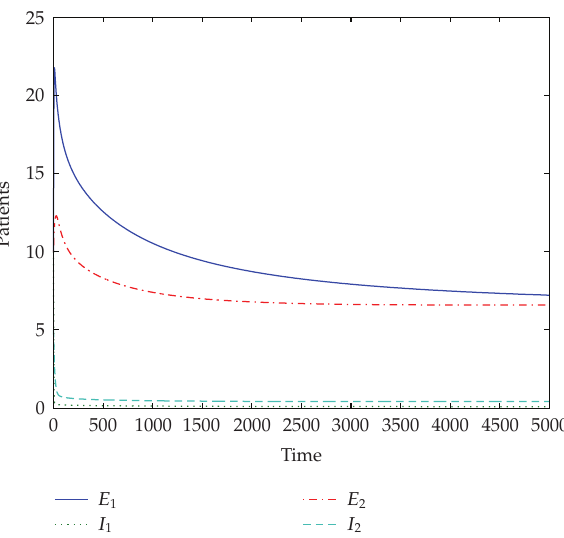
Figure 10: Trajectories of system (cid:2) 2.2 (cid:3) when β 1 (cid:2) N (cid:3) (cid:8) β 1 /N , β 2 (cid:2) N (cid:3) (cid:8) β 2 /N , β 1 (cid:8) 1, β 2 (cid:8) 0 . 25, d 1 (cid:8) 0 . 02, d 2 (cid:8) 0 . 07, so that R 1 > H , R 2 < f (cid:2) R 1 (cid:3) . It shows that the interior equilibrium P 2 is stable.